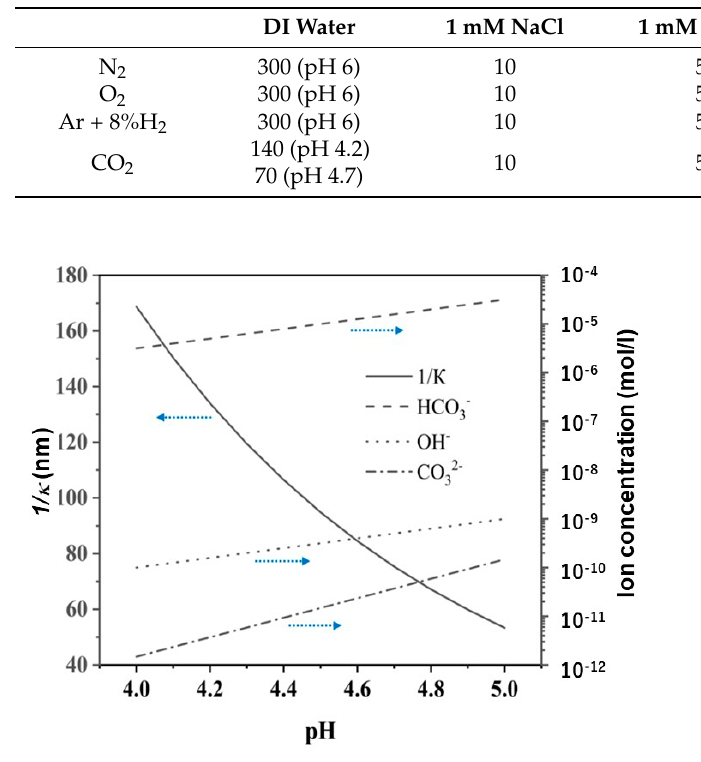
Figure 6. Debye length (1/ κ ) around CO 2 bubbles (left axis) and HCO 3 − , OH − , CO 32 − ion concentra- tion in the presence of CO 2 nanobubbles in deionized water (right axis) as a function of pH. A thick electric double layer (300 nm, Table 3) is present around the N 2 , O 2 and Ar + 8%H 2 nanobubbles in deionized water and can stabilize those nanobubbles with high enough zeta potential (i.e., − 16 to − 32 mV, Figure 4A). On the other hand, the Debye length